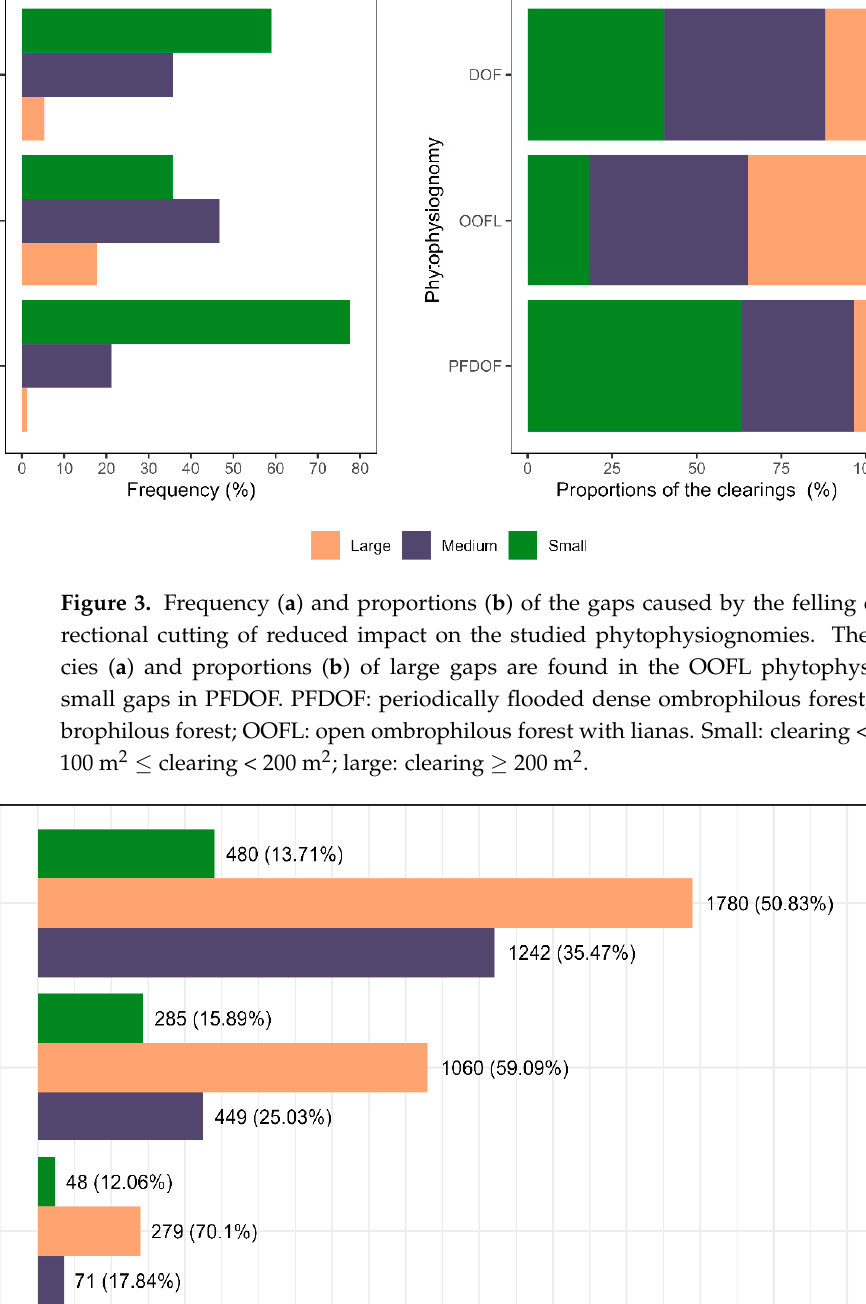
Table 5. Coe ffi cients and precision statistics of generalized linear models to predict the clearing size in an area of planned forest exploitation in the Brazilian Amazon.